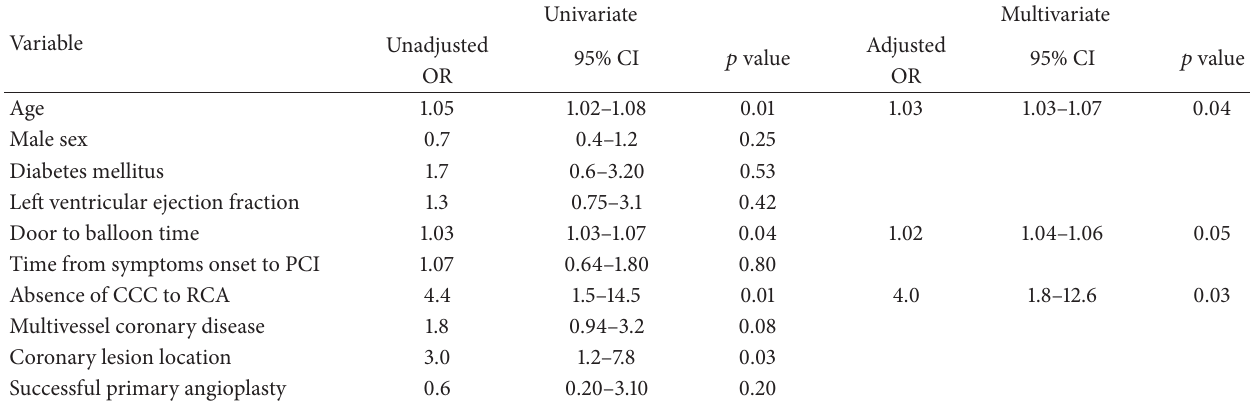
Table 4: Univariate and multivariate logistic regression analysis for in-hospital